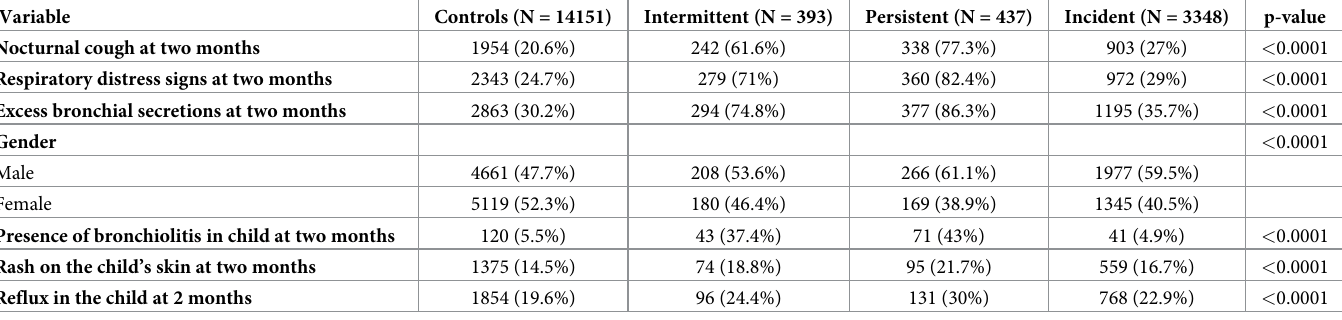
Table 3. Infant risk factors associated with wheezing phenotypes in ELFE